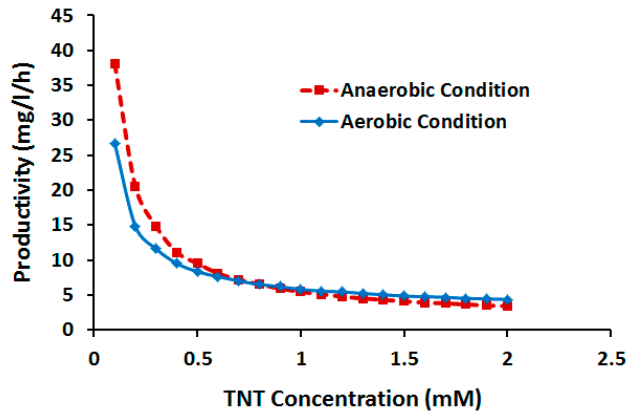
Figure 10. Productivity of TNT biotransformation vs. concentration.